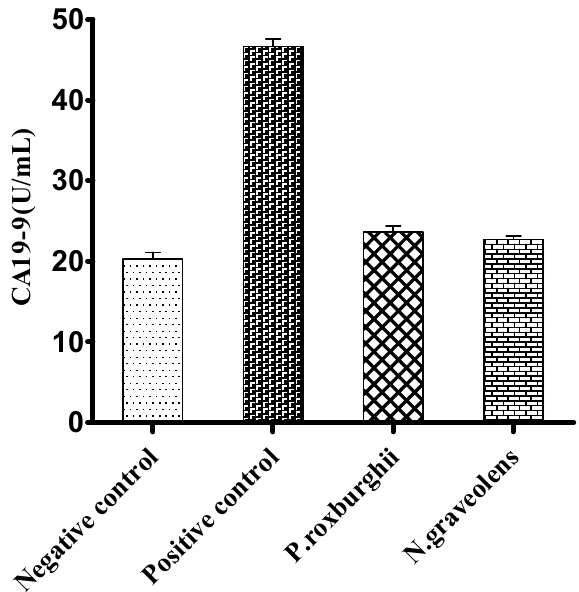
Figure 10. Level of serum CA19-9 in different groups.